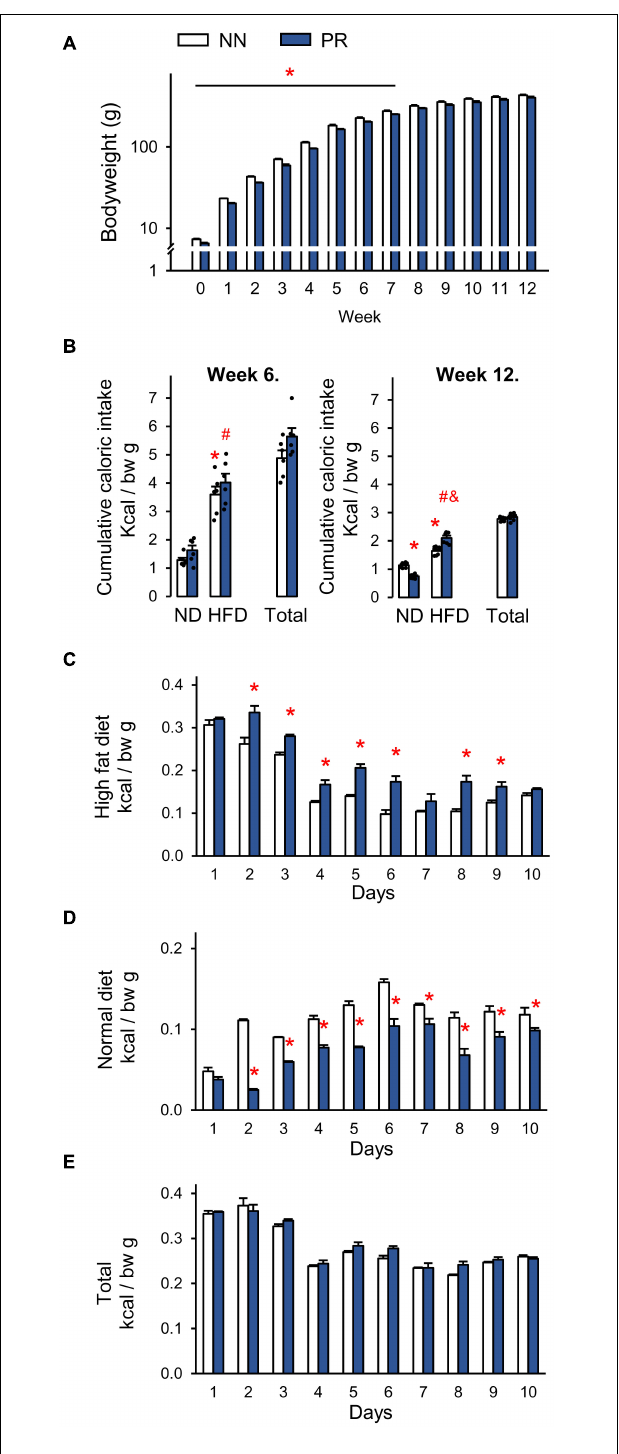
FIGURE 1 | Postnatal development of normal nourished (NN) and intrauterine protein restricted (PR) rats as well as relative caloric intakes of normal (ND) and high fat (HFD) diets. (A) Weekly bodyweights. PR rats had lower than normal bodyweight at birth (week 0) and until week 8. Student’s t -test, or Mann-Whitney U- test, NN vs. PR * p < 0.05, n = 6. Note the logarithmic scale on the y axis. (B) Caloric intakes of ND and HFD. Both diets were offered for